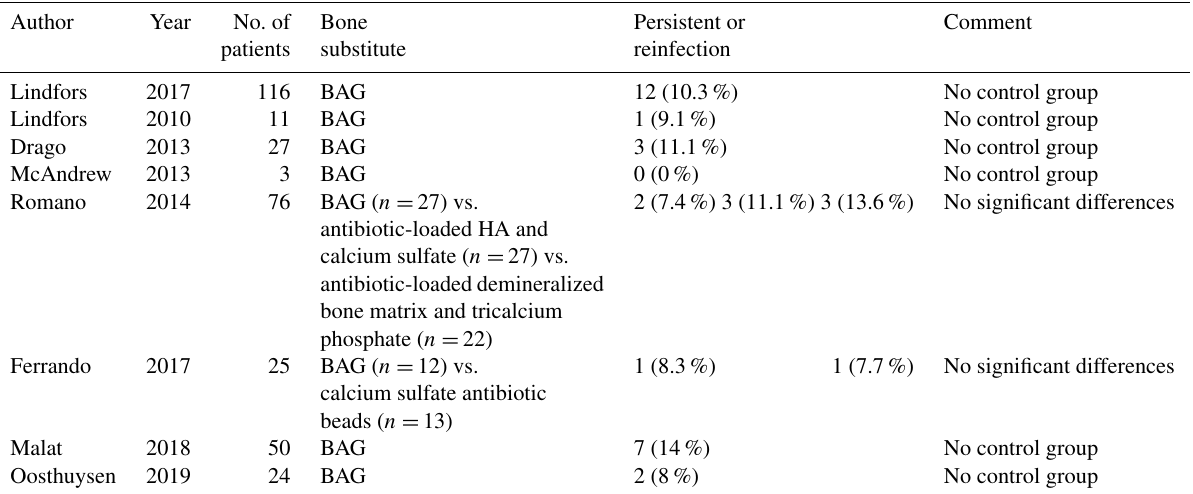
Table 4. Clinical studies investigating the use of bioactive glass S53P4 in patients with chronic osteomyelitis; reviews and animal and in vitro studies are not